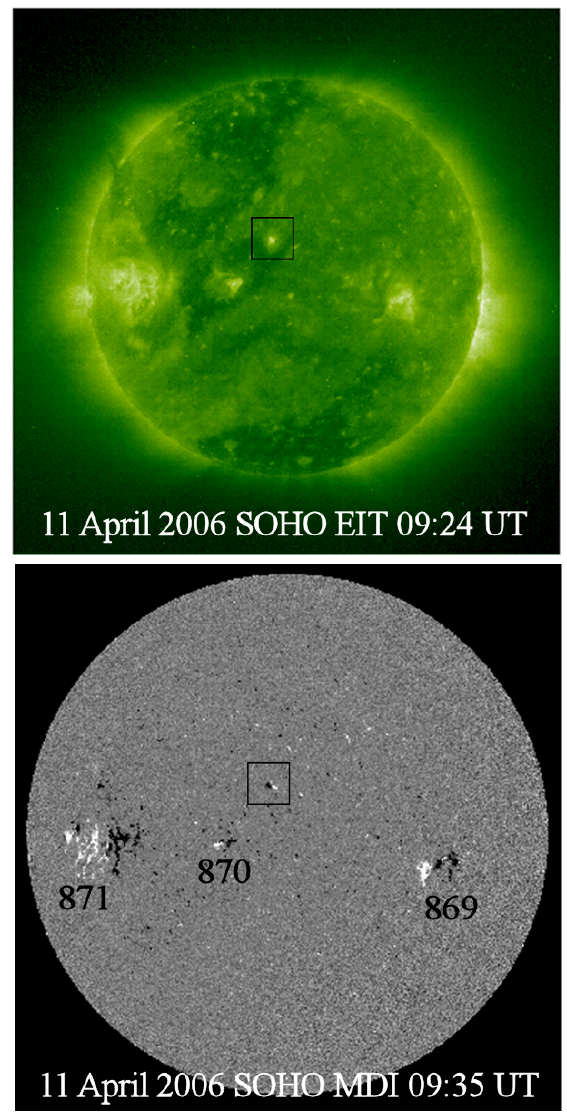
Fig. 4. The locations of all of the active regions on the visible disk of the Sun at the time at which the CME associated with the mag- netic cloud erupted. At 09:24UT on 11 April 2006, there are four active regions on the Sun observed by SOHO/EIT at 195 ˚A and ob- served a short time later by SOHO/MDI. The eruption originates from a small, spotless active region located slightly north east of disk centre (shown within the boxes). AR10869 is located towards the west limb, and AR10870 and AR10871 are both located east of the central meridian. All of the active regions that have been al- located NOAA active region numbers are situated in the Southern solar